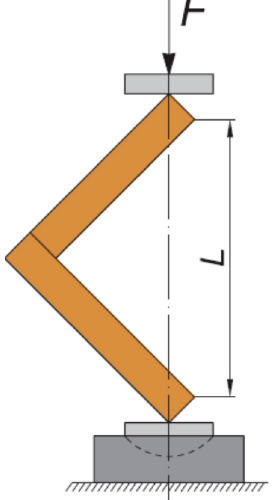
Figure 4. Type of loading of the tested samples [78].